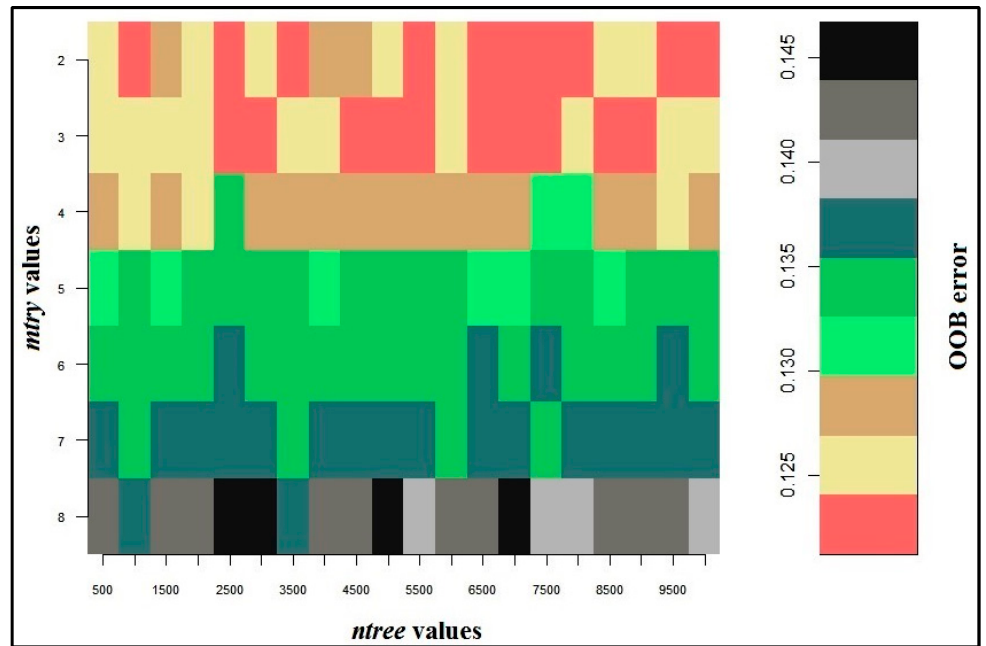
Figure 4. Results of random forest optimization. The OOB error was calculated using a 10-fold cross validation (CV) and the training data sets.